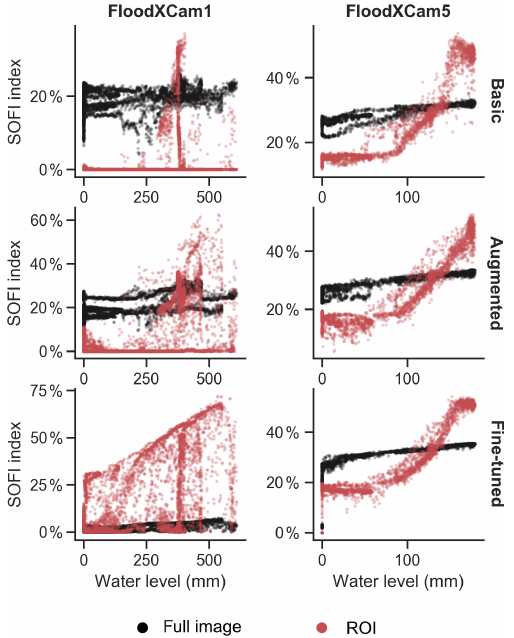
Figure 7. Videos with reference measurements: SOFI computed from full images (black) or from a ROI (red) plotted against mea- sured water level for different training strategies. The reduction of noise and systematic errors with the Fine-tuned strategy is